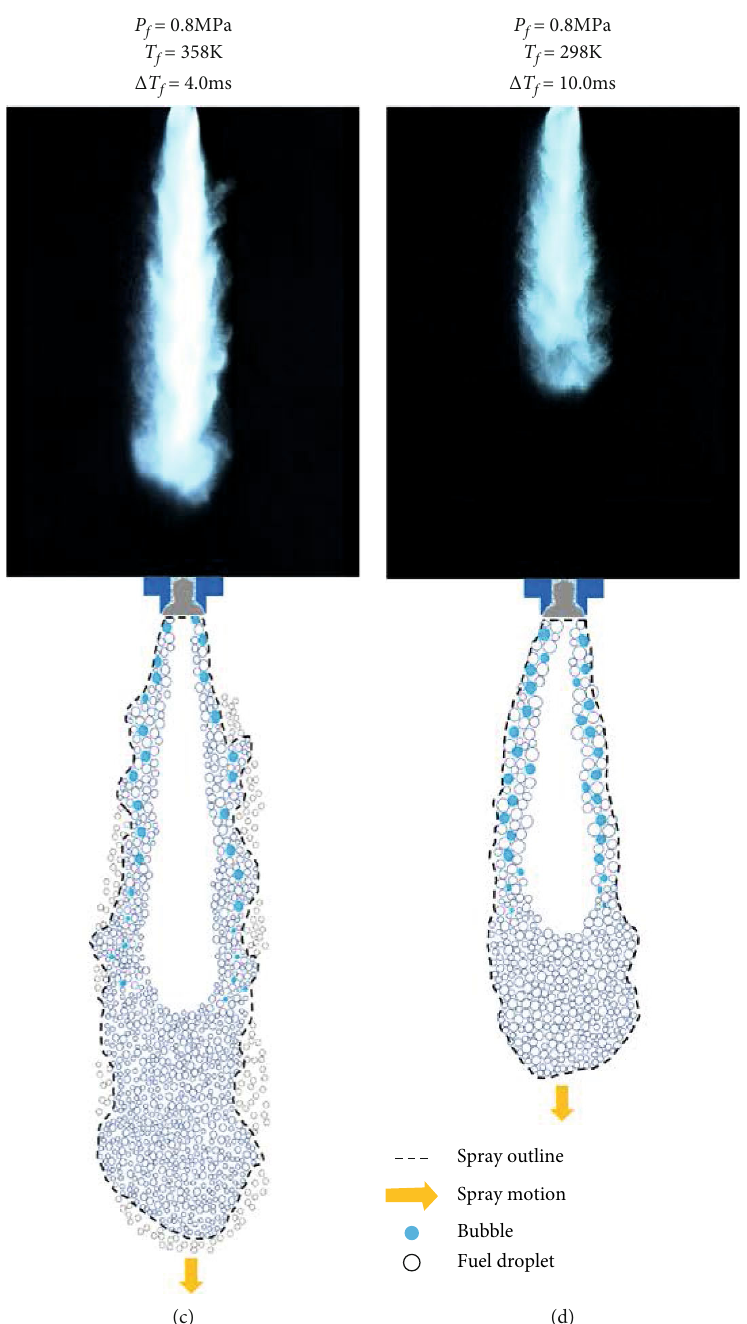
Figure 19: Comparison of spray shapes under di ff erent air-assisted injection control parameters ( t = 2 : 5ms